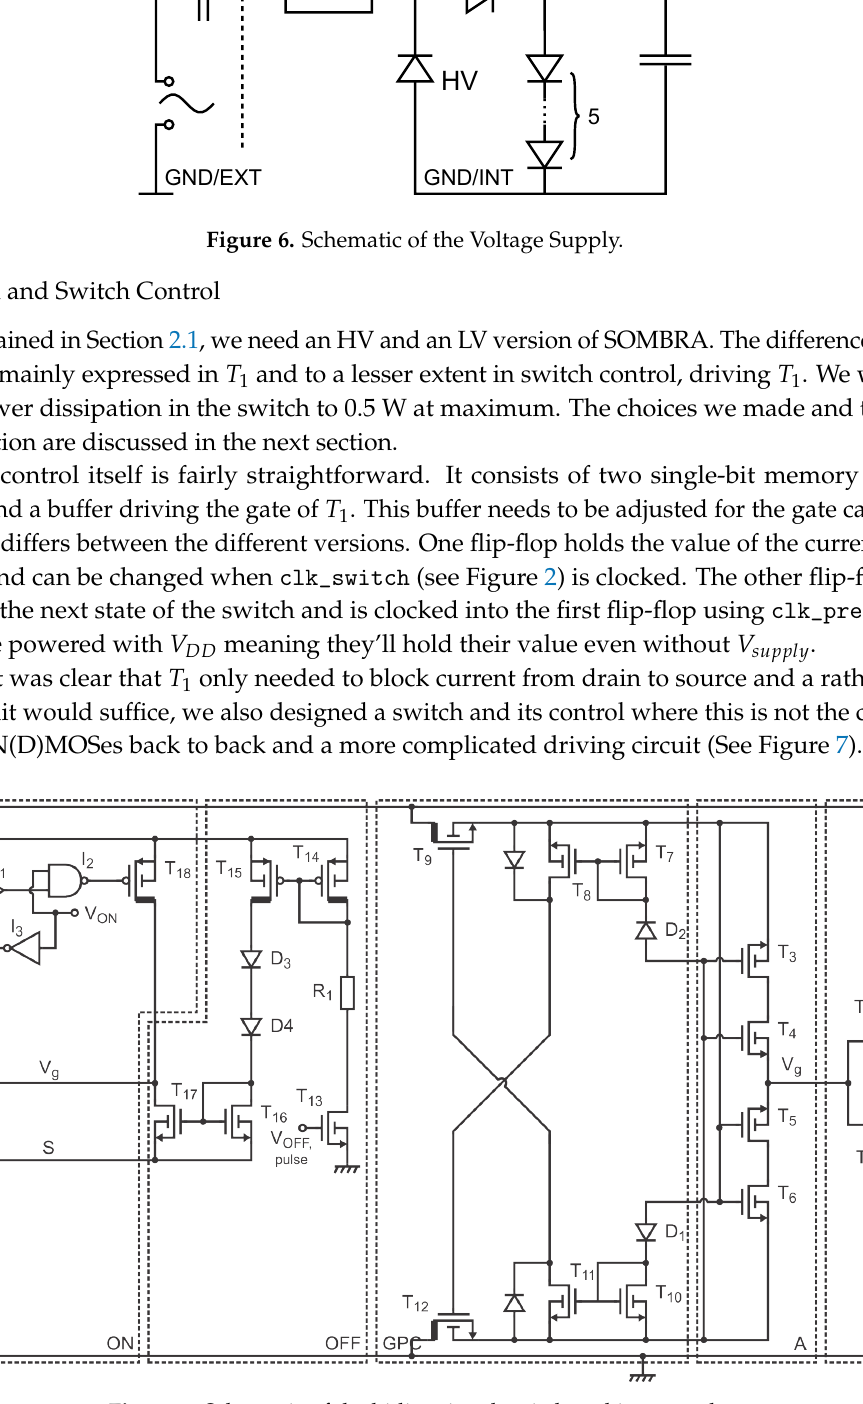
Figure 7. Schematic of the bidirectional switch and its